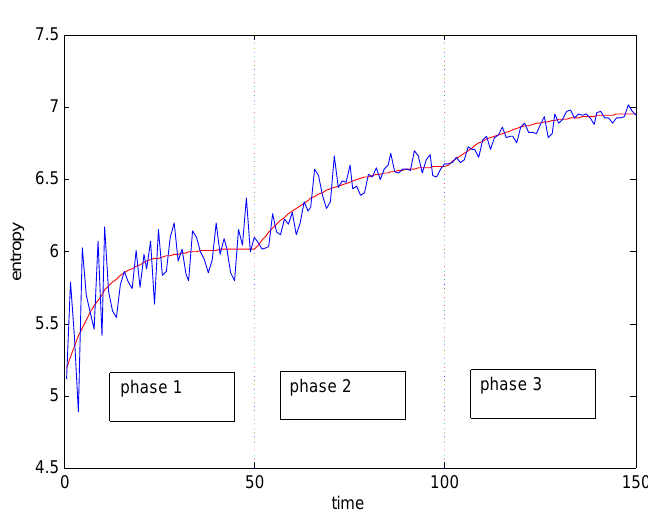
Figure 7: Illustration of multi-phase entropic